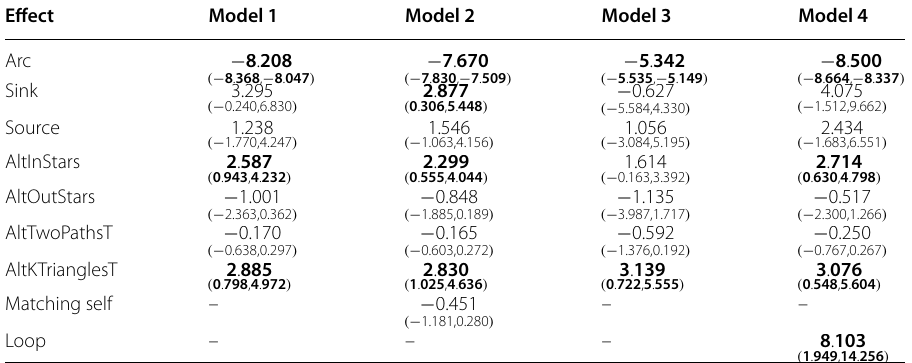
Table 6 Parameter estimates with 95% confidence interval for the Alon E. coli regulatory network